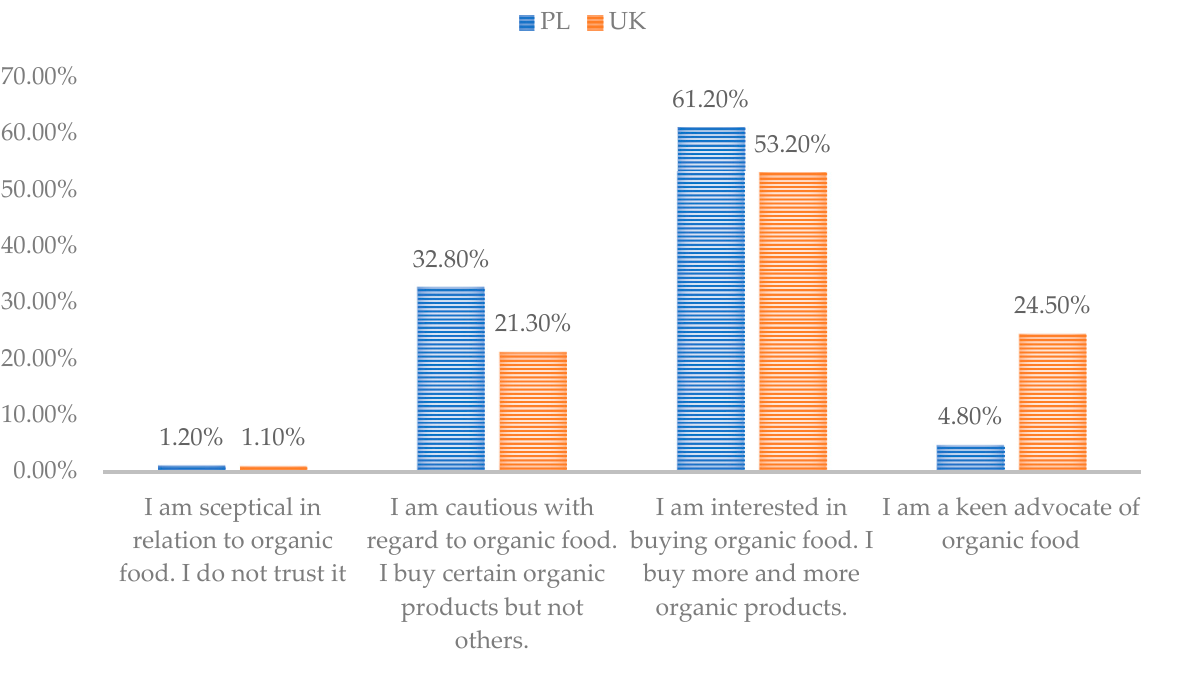
Figure 1. Attitude towards organic products among people purchasing organic food in the surveyed countries.